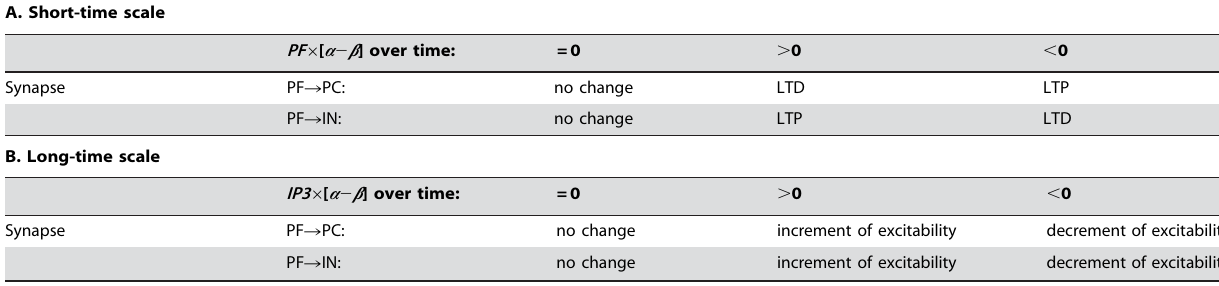
Table 1. Learning rules for two different time